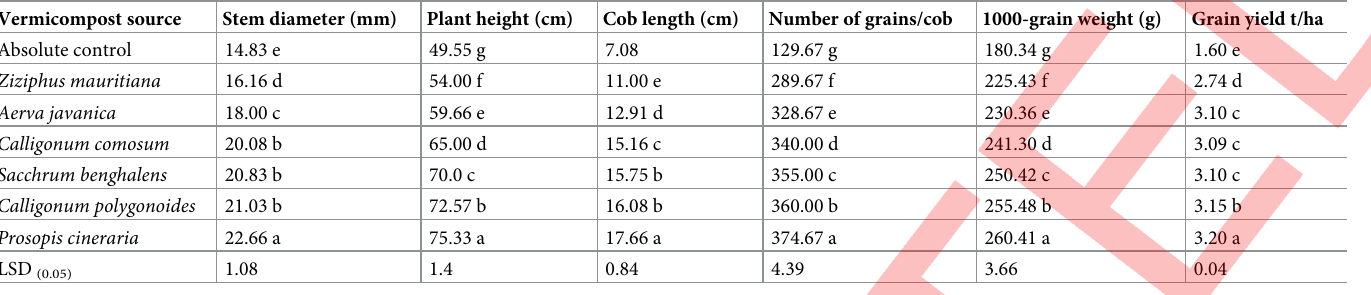
Table 4. The impact of different vermicompost treatments on growth and yield attributes of maize crop. Vermicompost source